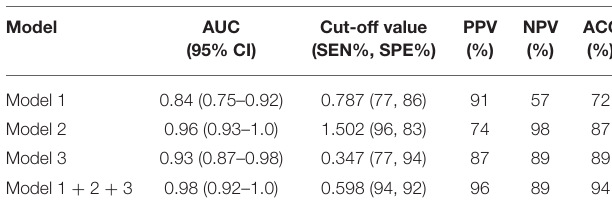
TABLE 4 | Diagnostic performance of imaging feature-based (Model 1), texture feature-based models in arterial phase (Model 2), and portal phase (Model 3), and the combined model (Model 1 + 2 + 3) for differentiating MFP from